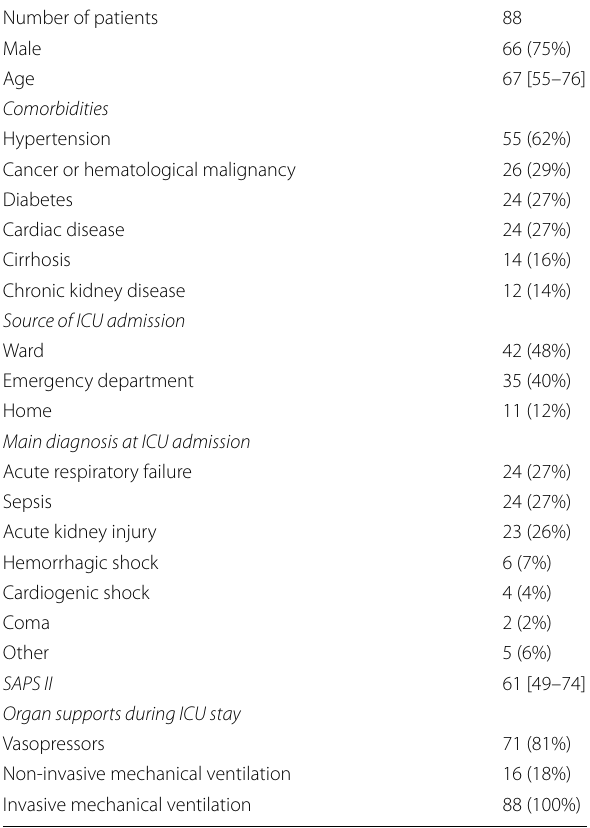
Table 1 Characteristics of